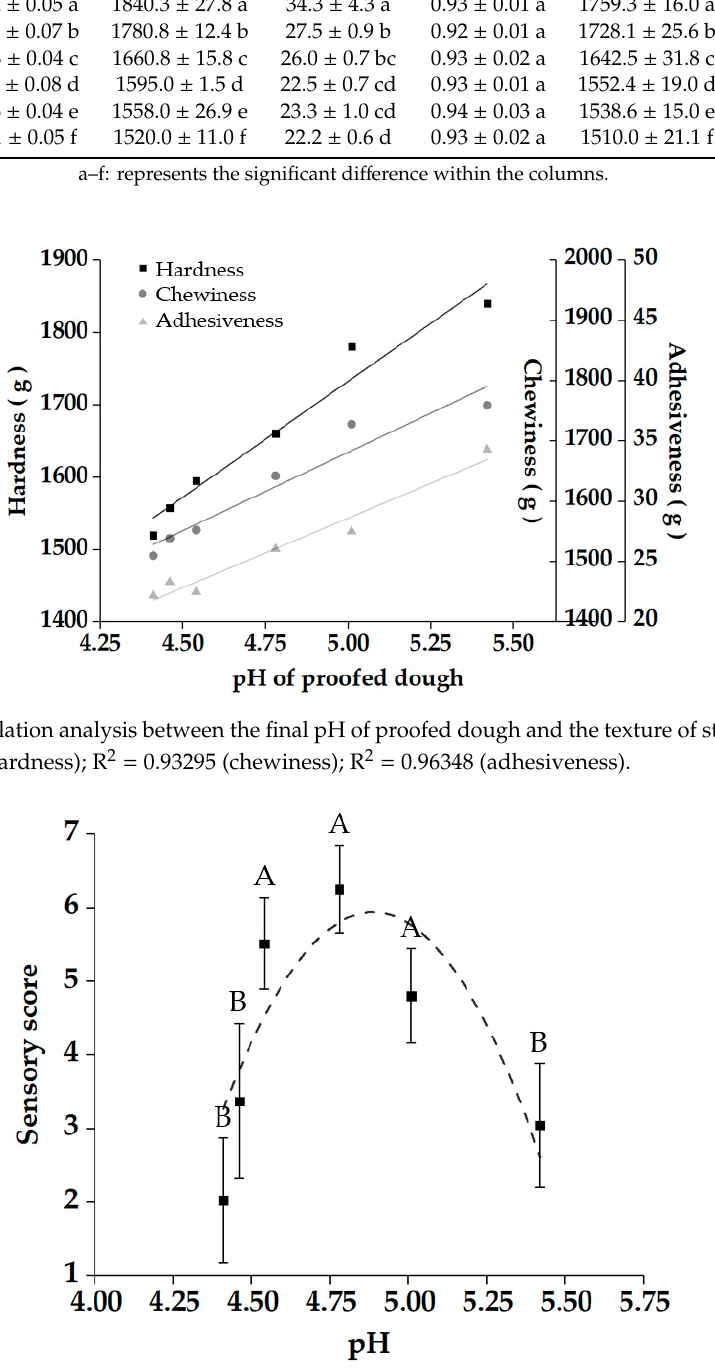
Figure 3. Effects of the final pH of proofed dough on steamed bread sensory evaluation. All data are the means ± standard deviation. Sensory score: 1: very unacceptable; 2: unacceptable; 3: mildly unacceptable; 4: neither unacceptable nor acceptable; 5: mildly acceptable; 6: acceptable; and 7: very